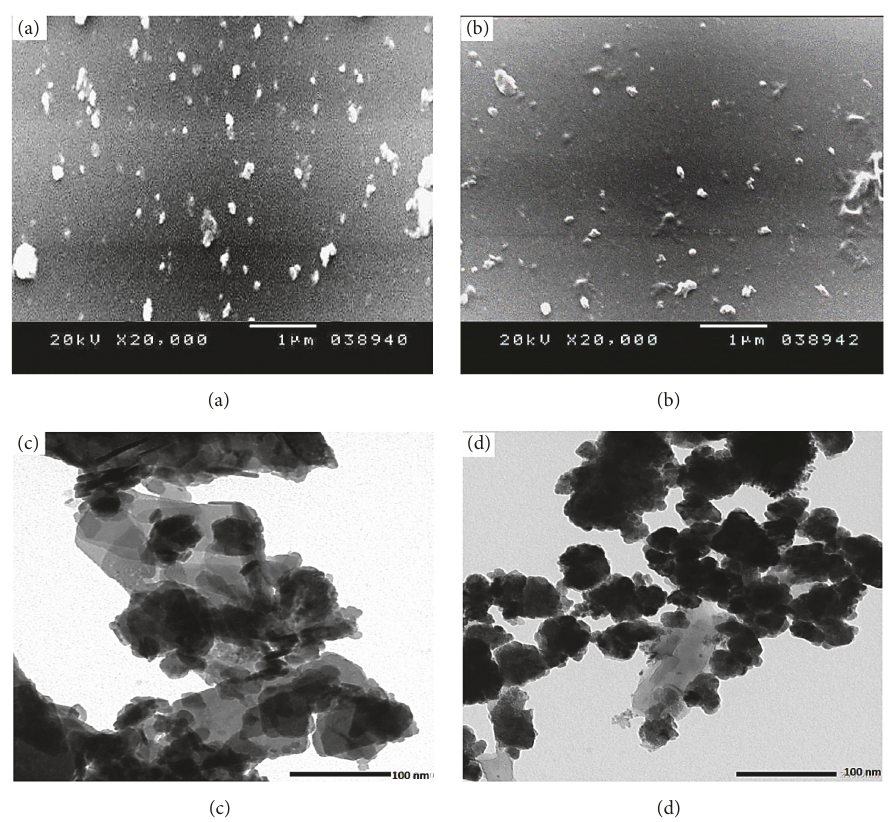
Figure 2: Electron microscopy images of Ch-MO NPs. (a), (b) The SEM of Ch-CuO NPs and Ch-ZnO NPs, respectively. (c), (d) The TEM of Ch-CuO NPs and Ch-ZnO NPs, respectively. Scale bar for SEM measurements was 1 𝜇 m and magnification x20000 at 20 Kv. Scale bar for TEM measurements was 100nm and magnification x40000 at 20